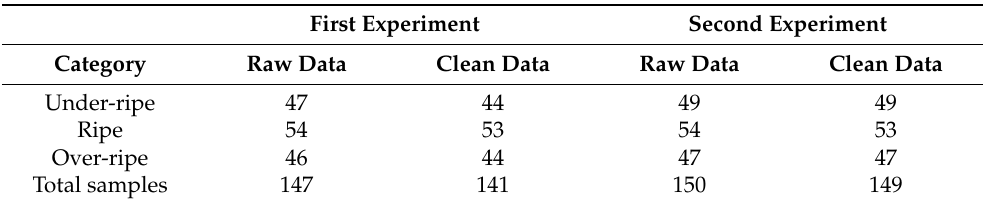
Table 2. Total number of samples before and after removal of outliers.